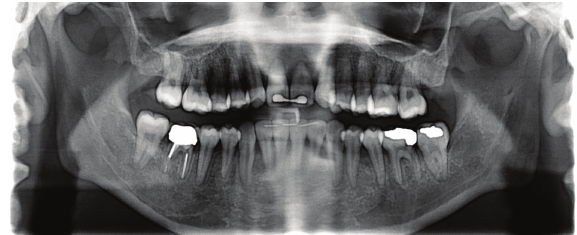
Figure 10: Posttreatment panoramic radiograph.